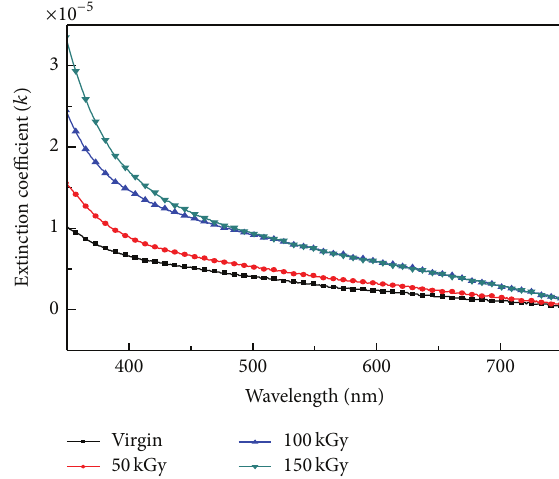
Figure 5: Variation of extinction coefficient 𝑘 as a function of